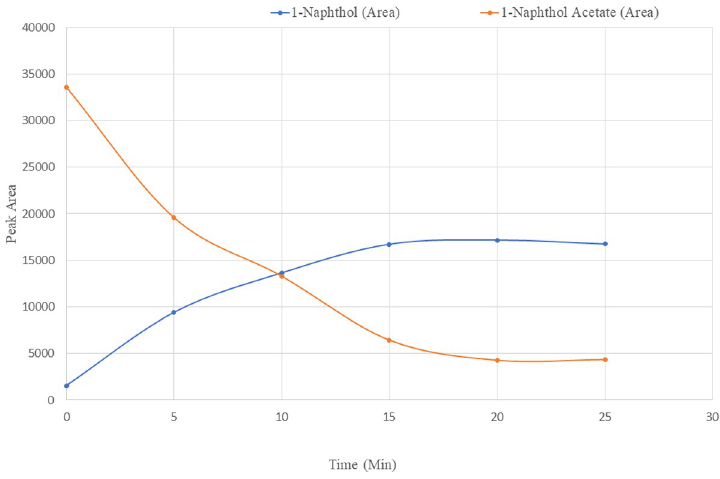
Fig 5. 1-naphthol acetate conversion to 1-naphthol by AChE in blood at different time intervals.